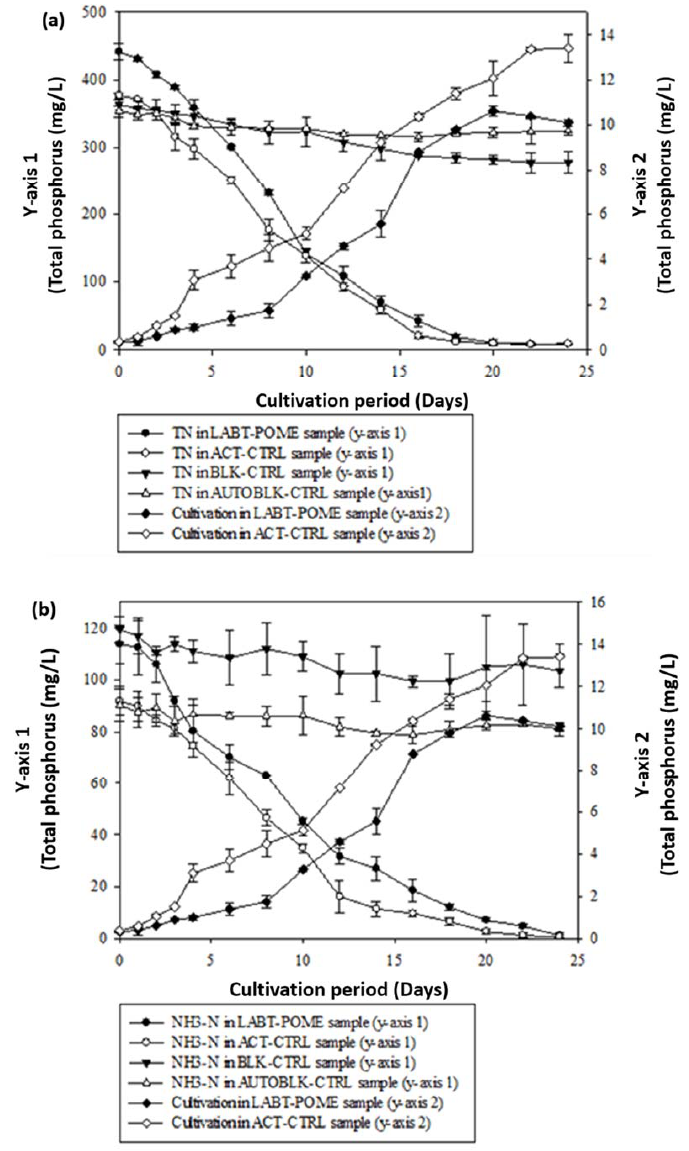
Figure 4. ( a ) Chlorococcum oleofaciens removes total nitrogen (TN) and ( b ) ammonia nitrogen from LABT-POM.